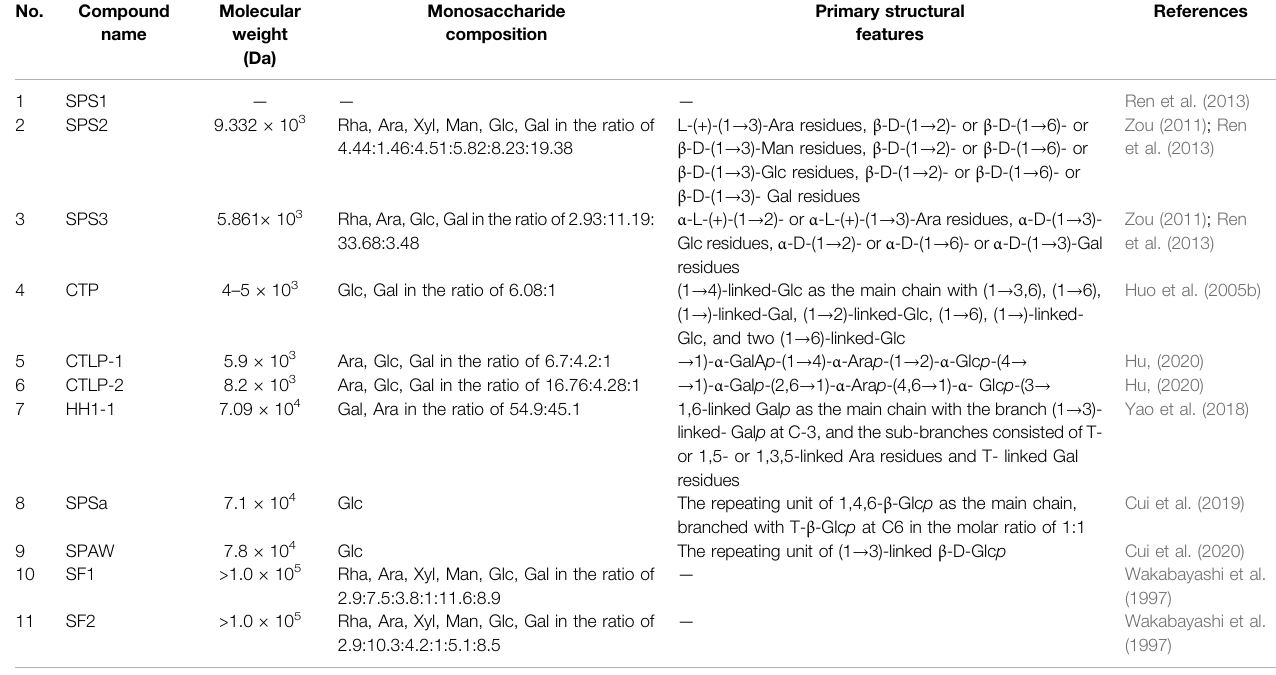
TABLE 2 | The polysaccharides isolated from fl ower of saf fl ower: chemical structure. No.